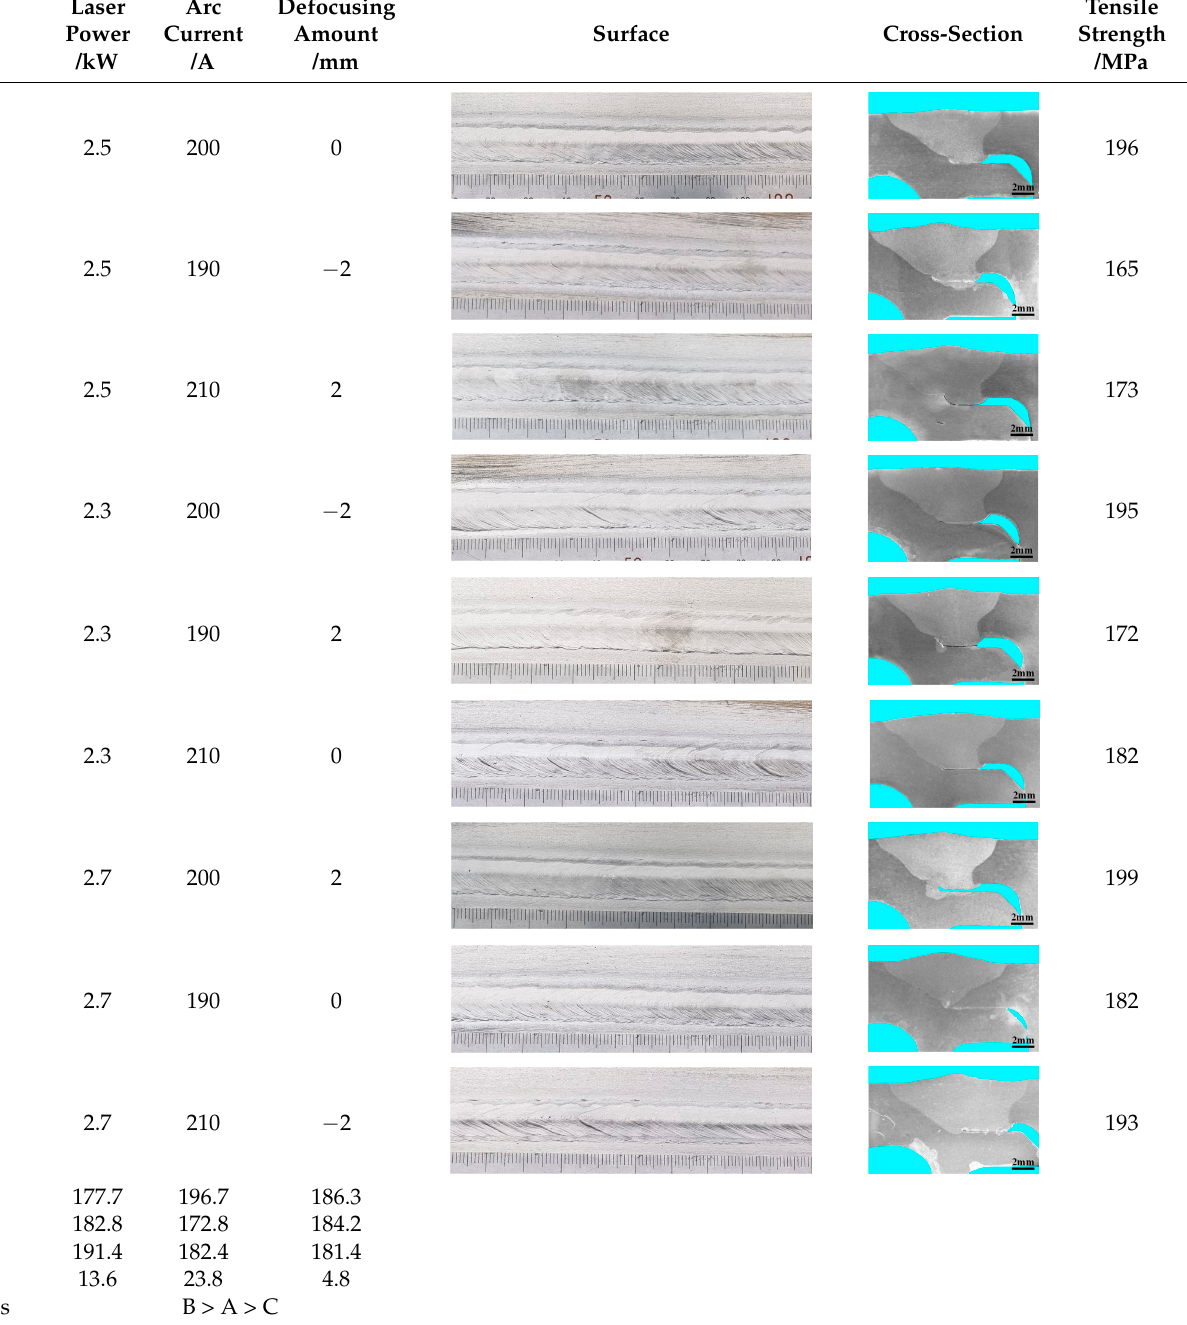
Table 3. Welding parameters, experimental, and range analysis results of the orthogonal test.